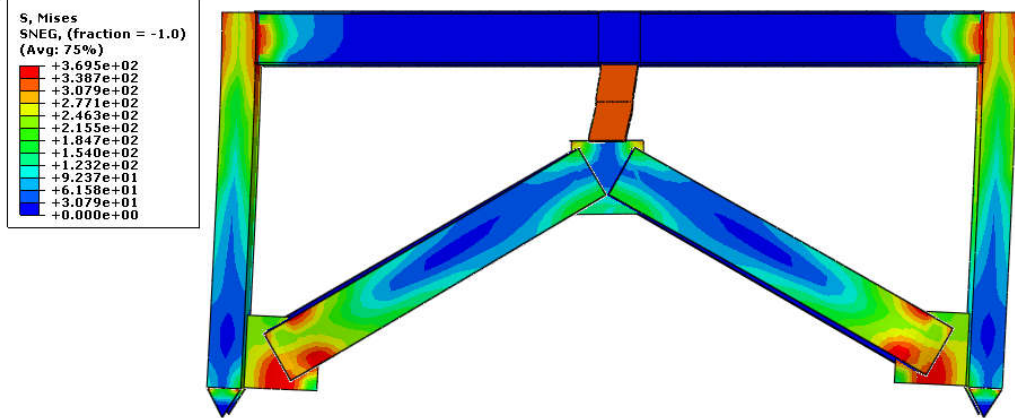
Figure 10. Stresses in the eccentrical braced frame (kN/mm 2 ).